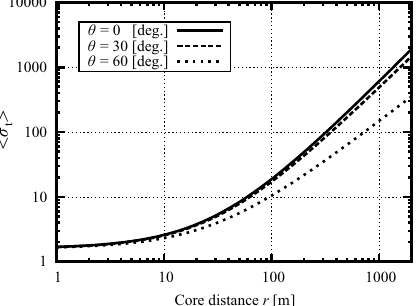
Figure 2. The relation between r and (cid:4) σ t (cid:5) . Each curve is Eq. (1) for θ = 0 ◦ , 30 ◦ , 60 ◦ , respectively. The averaged θ is ∼ 23 ◦ in